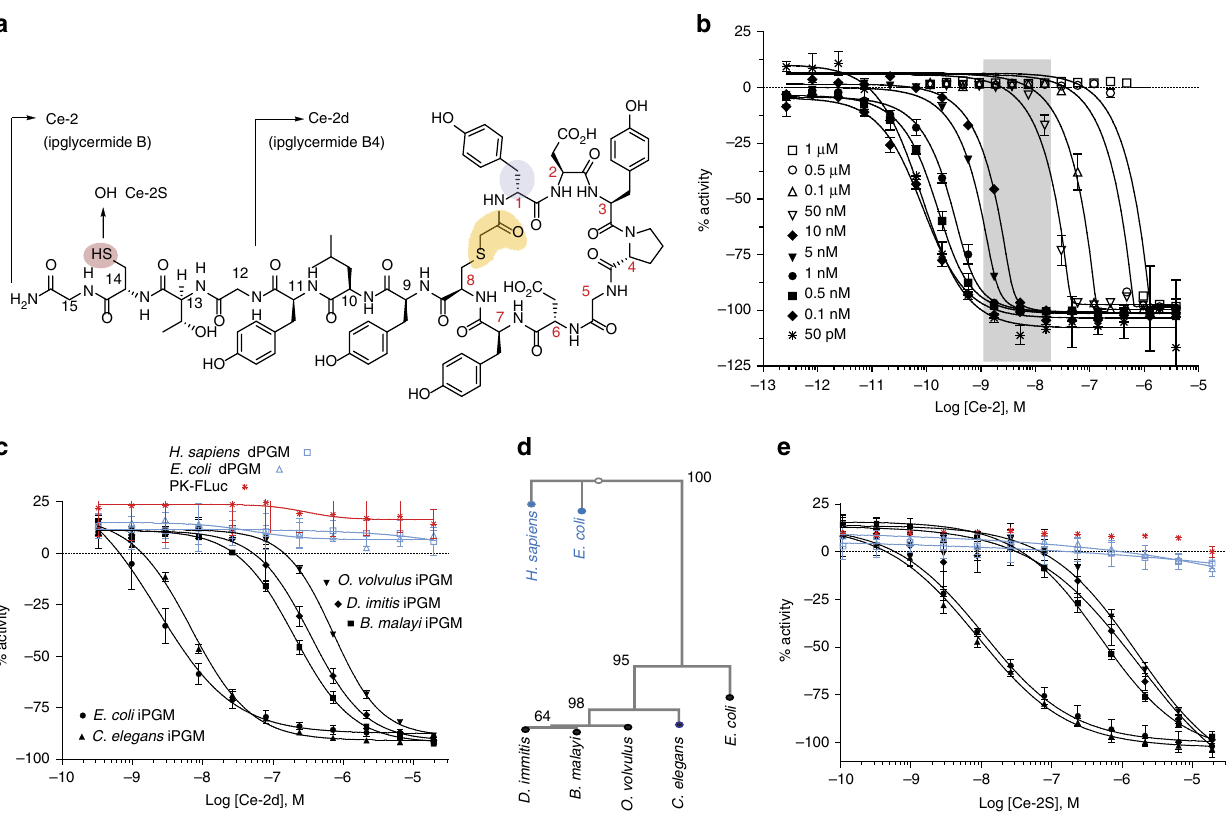
Figure 2 | Pharmacologic–phylogenetic relationship of iPGM macrocyclic peptide inhibitor. ( a ) Structure of the Ce-2 macrocycle obtained from affinity selection showing truncation to give Ce-2d and position of Cys14Ser substitution. Note the thioether bond (yellow), D -tyrosine (blue), and thiol of Cys14 (light red). ( b ) IC 50 dependence of Ce-2 on C. elegans iPGM enzyme concentration (50pM to 1 m M), grey region indicated concentration range for PGMs used in initial inhibitory activity profiling obtained in Table 1. ( c ) Concentration-response curves for characterization of Ce-2d on the iPGM orthologues and dPGM isozymes. ( d ) Phylogenetic tree constructed for amino-acid sequence alignments of seven species orthologues and isozymes of PGM. Percentage bootstrap values based on 1,000 replicates are indicated at branch nodes. ( e ) Concentration-response curves for characterization of Ce-2S on the iPGM orthologues and dPGM isozymes. All data determined from the enzyme-coupled bioluminescent assay; PGM concentrations as indicated in Table 1. Plots are representatives from individual experiments ( N ¼ 3); error bars are standard deviations values of technical